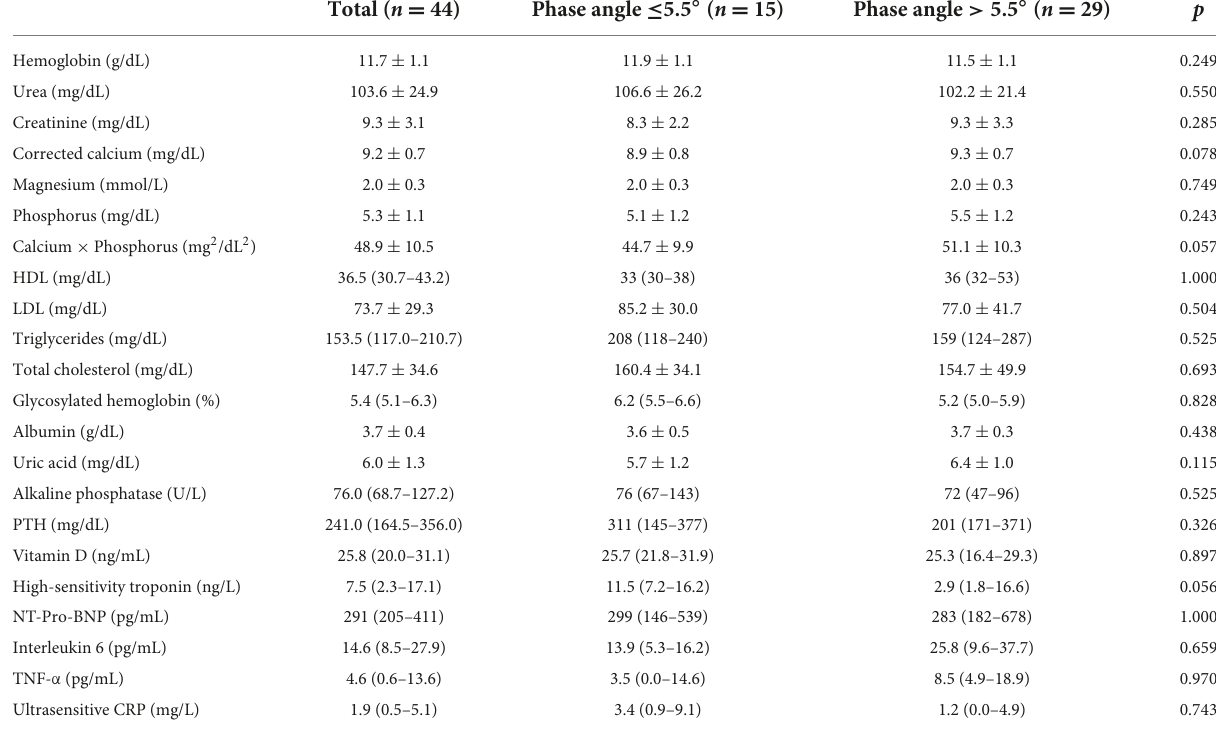
TABLE 3 Laboratory tests of peritoneal dialysis (PD) patients.